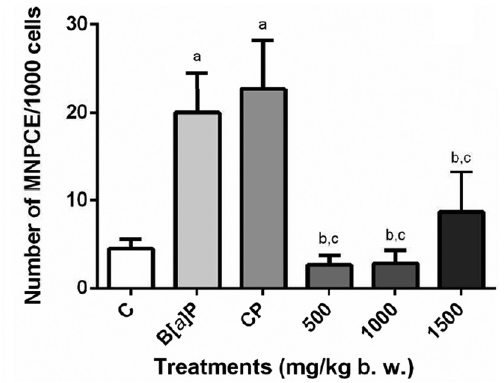
Figure3 -FrequencyofMNPCEsinmousebonemarrowafteracutetreat- ment with three different concentrations (500, 1000, and 1500 mg/kg bw) of the S. dulcis bark ethanolic extract. Shown are the means (cid:2) SD for 10 animals (male and female) from each treatment. Statistical analysis was performed using ANOVA and Tukey’s test ( p <0.05). a Statistically differ- ent from negative control group; b statistically different from B[ a ]P con- trol group. c Statistically different from CP control group. MNPCE: micro- nucleated polychromatic erythrocyte; C: distilled water; B[ a ]P: benzo[ a ]pyrene; CP: cyclophosphamide.